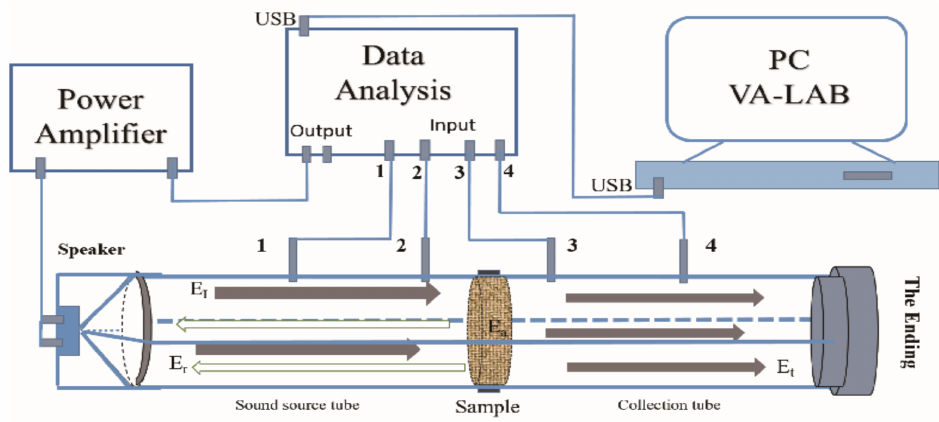
Figure 1. Scheme of impedance tube for measuring STL with four